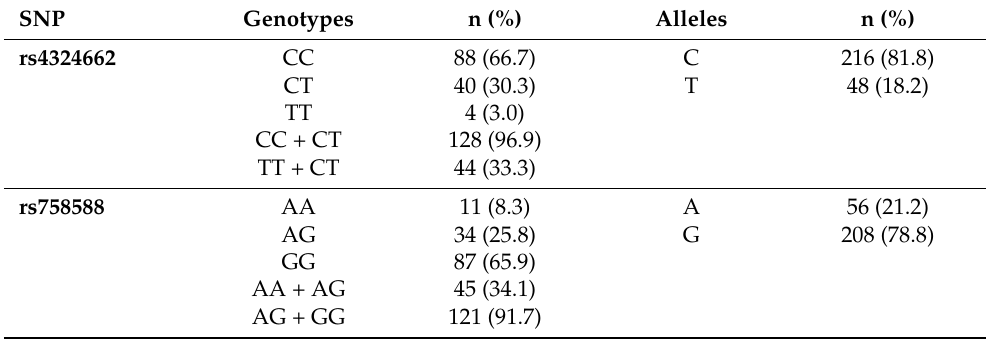
Table 2. The frequencies of genotypes, and alleles of analyzed SNPs of the PDGFRB